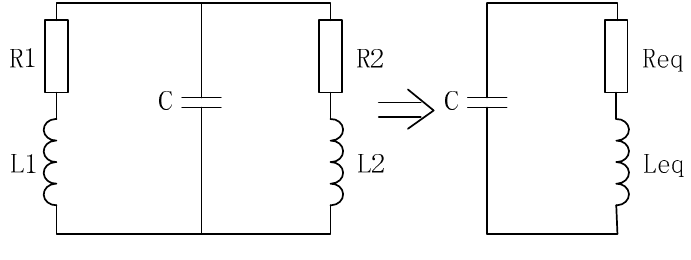
Figure 6. The equivalent convert of the RLC circuit.